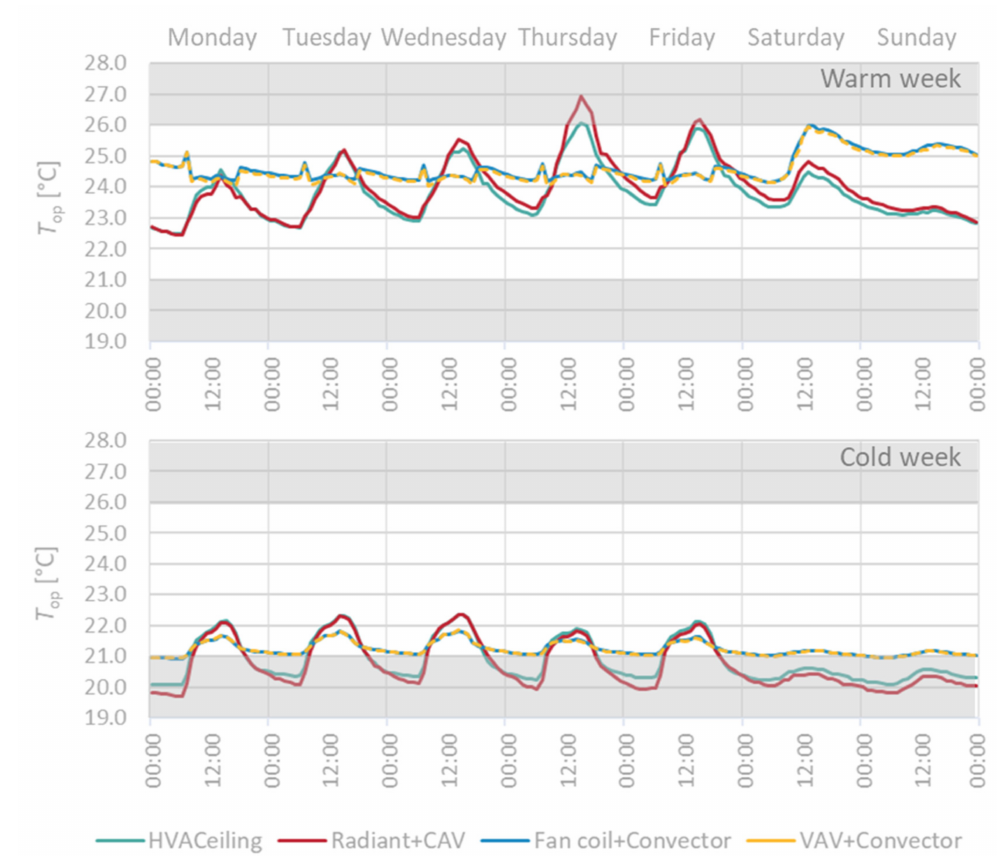
Figure 11. Operative temperatures ( Top ) for a warm week in July (12th − 18th) and a cold week in March (8th −